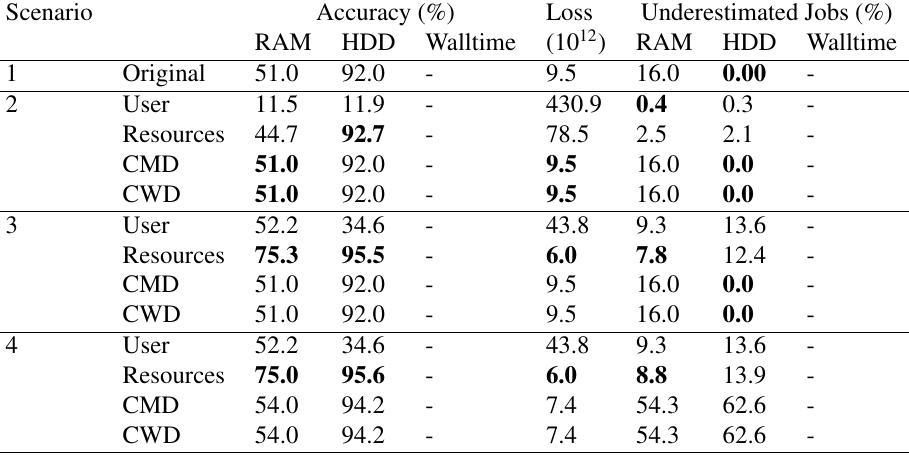
Table 3. Detailed statistics for original request and clustering in the GridKa dataset when using the ideal sliding window per user, determined on 80% of each user’s jobs, combined with the use of the local and global user profile to make predictions for new users or new workflows Lower values for the rating and percentage of underestimated jobs and higher values for accuracy are